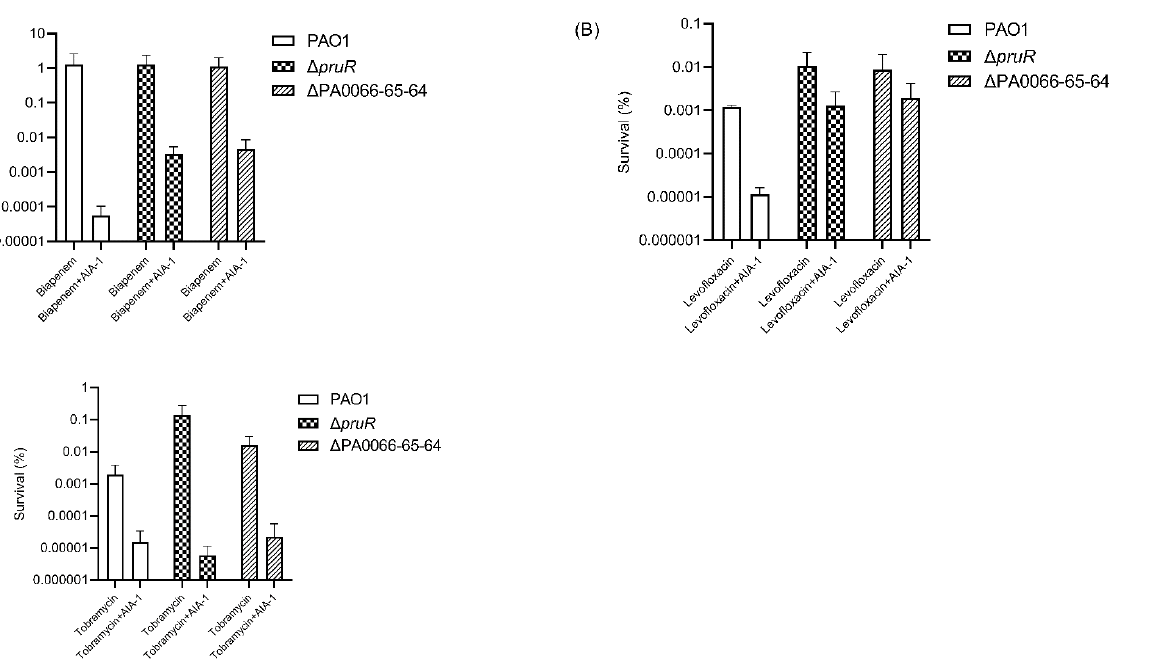
Figure 2. Killing effect of antibiotics or a combination of antibiotics and AIA-1 on PAO1 and deletion mutants. Survival rate of PAO1 and deletion mutants in a ( A ) biapenem killing assay, ( B ) levofloxacin killing assay, and ( C ) tobramycin killing assay. Error bars show SD for three independent ex ‐ periments.